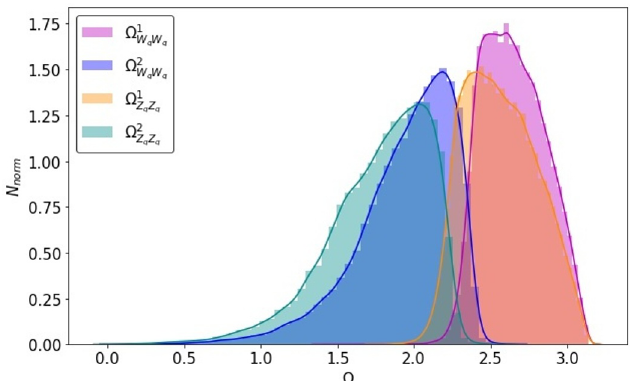
Figure 11 . Distributions of the largest ((cid:10) 1 ) and the second largest ((cid:10) 2 ) included angles between the paired jet ancestral partons, for the W q W q and Z q Z q events. Here one of the paired partons is required to be the most energetic among the four, and another one to be from a di(cid:11)erent parent particle.